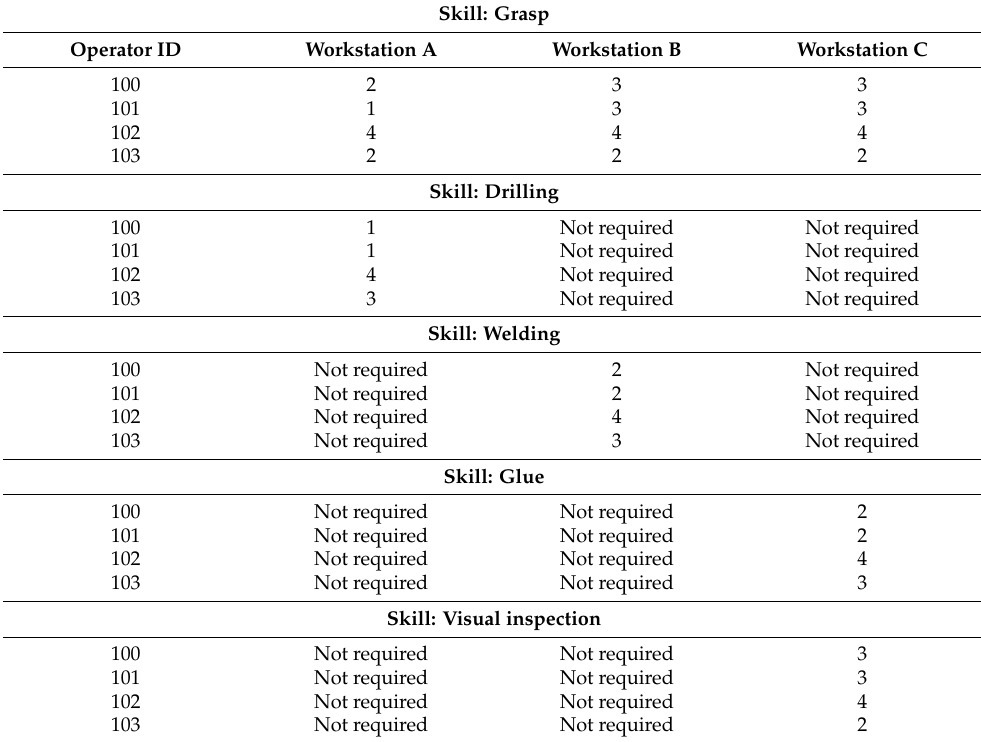
Table 4. Use case multi-attribute skill